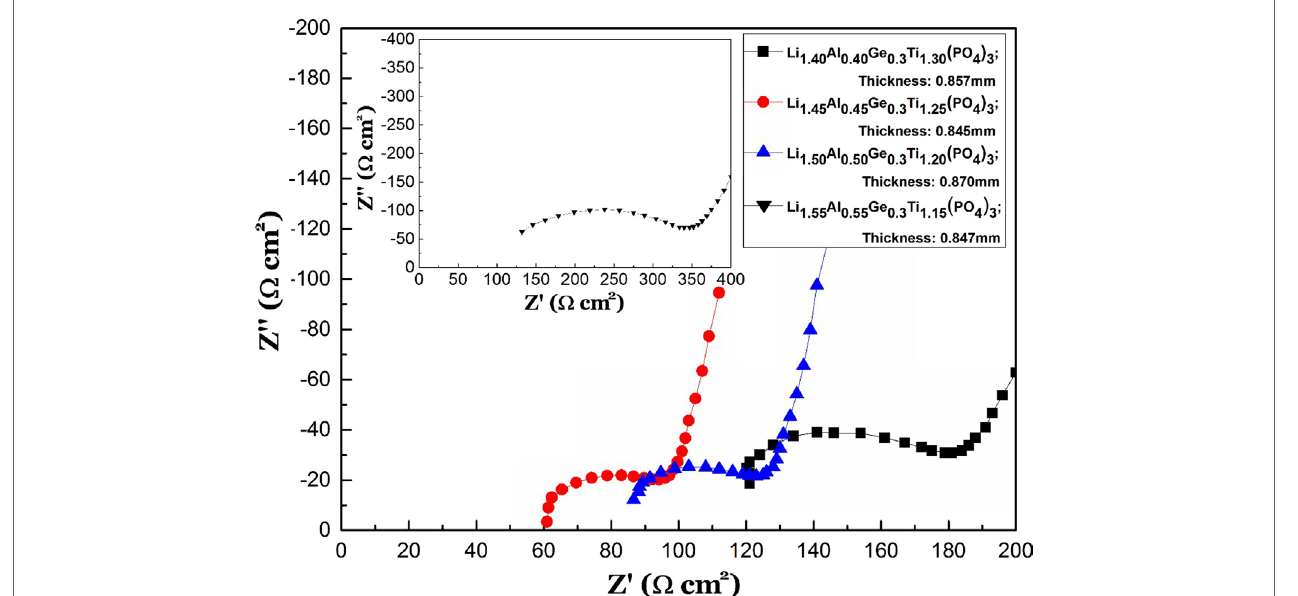
FigUre 10 | impedance profiles measured at 25°c of li 1 + x al x ge 0.3 Ti 1.7 − x (PO 4 ) 3 as a function of x